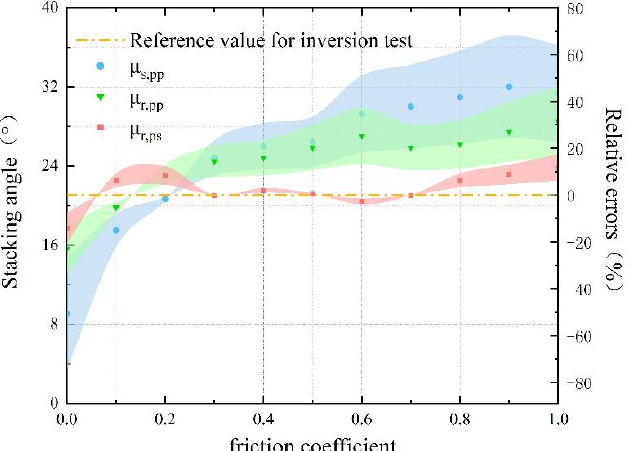
Figure 8. Belt error of the inversion test.